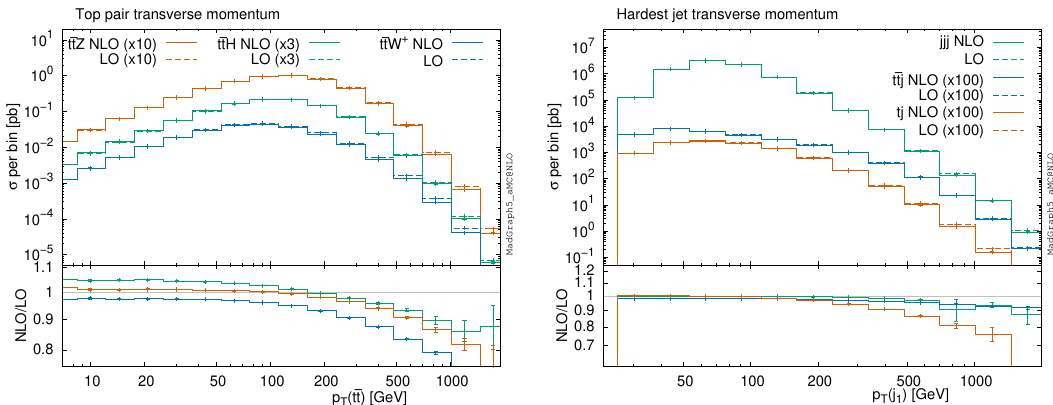
Figure 9. Top-pair transverse momentum in the processes of eq. (6.21) (left panel), and transverse momentum of the hardest jet in the processes of eq. (6.22) (right panel). Some of the histograms in the main frames are rescaled as indicated in order to enhance their